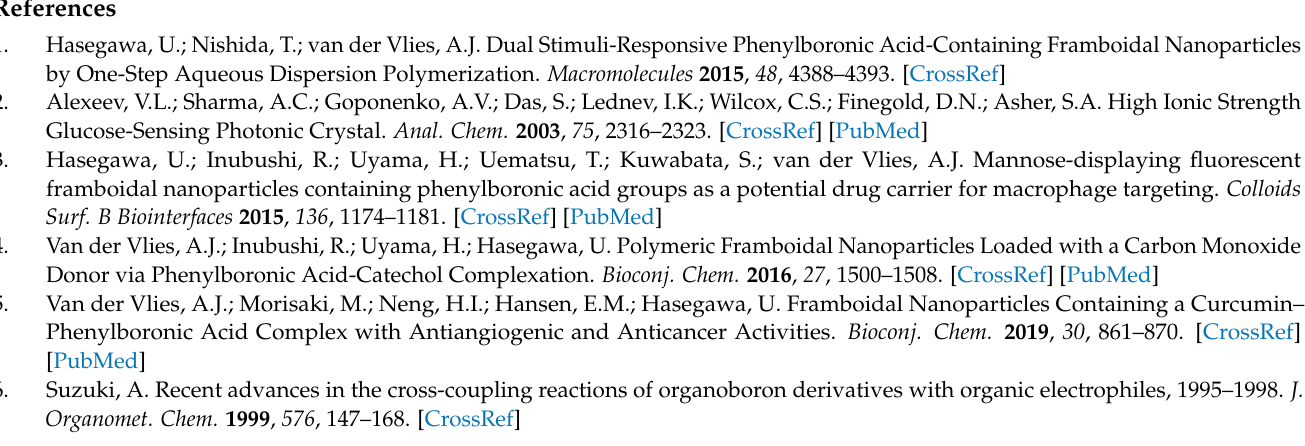
acid (B) model compound ( 1 ) and (C) boron model compound. Figure S2. IR spectra of (A) 3-(4- bromophenyl)propionic acid (B) model compound ( 2 ) and (C) boron model compound. Figure S3. IR spectra of (A) model compound ( 2 ), (B) BNP after reaction with 3-(4-bromophenyl)propionic and (C) BNP. Figure S4. IR spectra of (A) 4-iodo benzaldehyde (B) model compound ( 3 ) and (C) boron model compound. Figure S5. IR spectra of (A) model compound ( 3 ), (B) BNP after reaction with 4- iodobenzaldehyde and (C) BNP. Figure S6. IR spectra of (A) Tert-butyl 2-methylcarbazate, (B) Suzuki- Miyaura coupling partner ( 4 ) (C) model compound ( 4 ) and (D) boron model compound. Figure S7. IR spectra of (A) model compound ( 4 ), (B) BNP after reaction with Suzuki-Miyaura-coupling partner ( 4 ) and (C) BNP. Figure S8. IR spectra of (A) Tert-butyl 2-methylcarbazate, (B) Suzuki-Miyaura coupling partner ( 5 ) (C) model compound ( 5 ) and (D) boron model compound. Figure S9. IR spectra of (A) model compound ( 5 ), (B) BNP after reaction with Suzuki-Miyaura coupling partner ( 5 ) and (C) BNP. Figure S10. 1 H NMR spectrum of the boron model compound. Figure S11. 1 H NMR spectrum of Suzuki-Miyaura coupling partner ( 4 ). Figure S12. 1 H NMR spectrum of Suzuki-Miyaura coupling partner ( 5 ). Figure S13. 1 H NMR spectrum of model compound ( 1 ). Figure S14. 1 H NMR spectrum of model compound ( 2 ). Figure S15. 1 H NMR spectrum of model compound ( 3 ). Figure S16. 1 H NMR spectrum of model compound ( 4 ). Figure S17. 1 H NMR spectrum of model compound ( 5